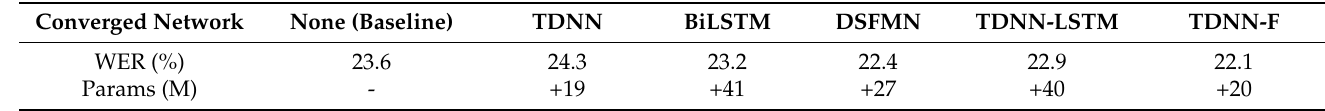
Table 7. The results of the fusion of different types of network structures are used, and “+” represents the increased parameter